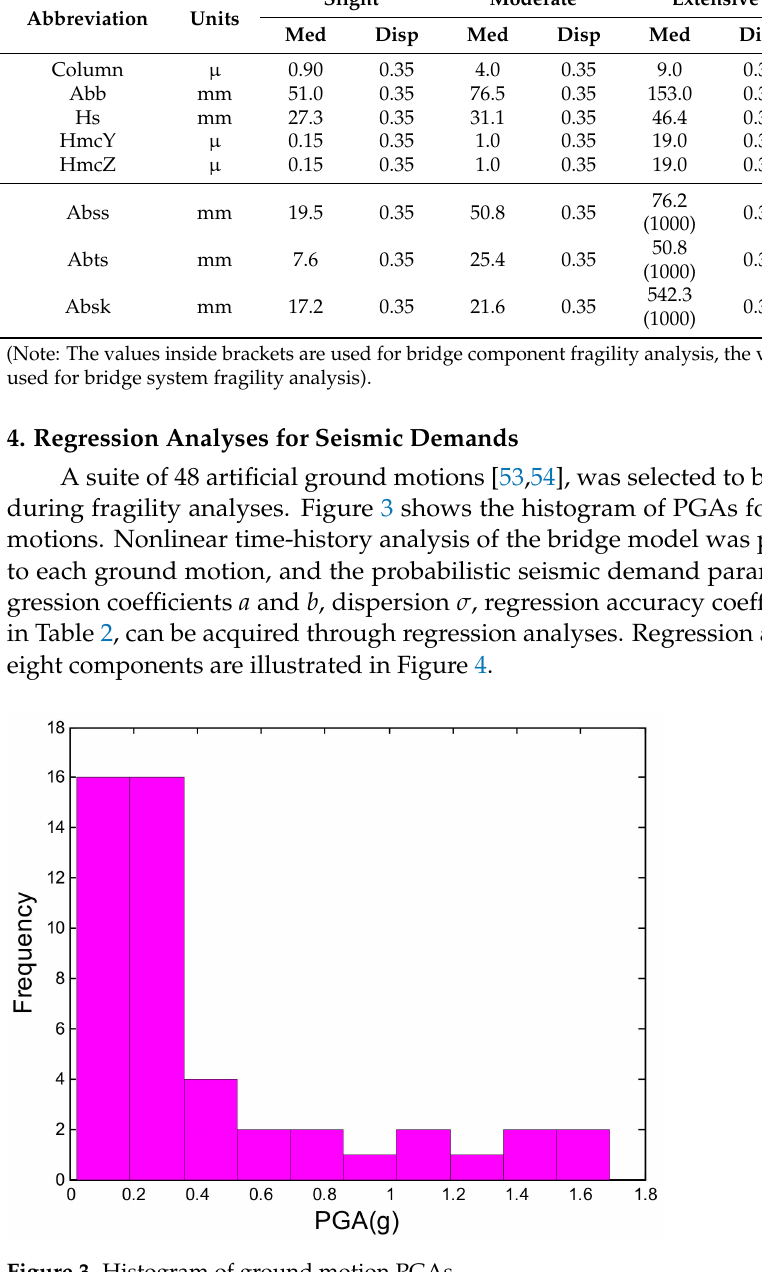
Figure 3. Histogram of ground motion